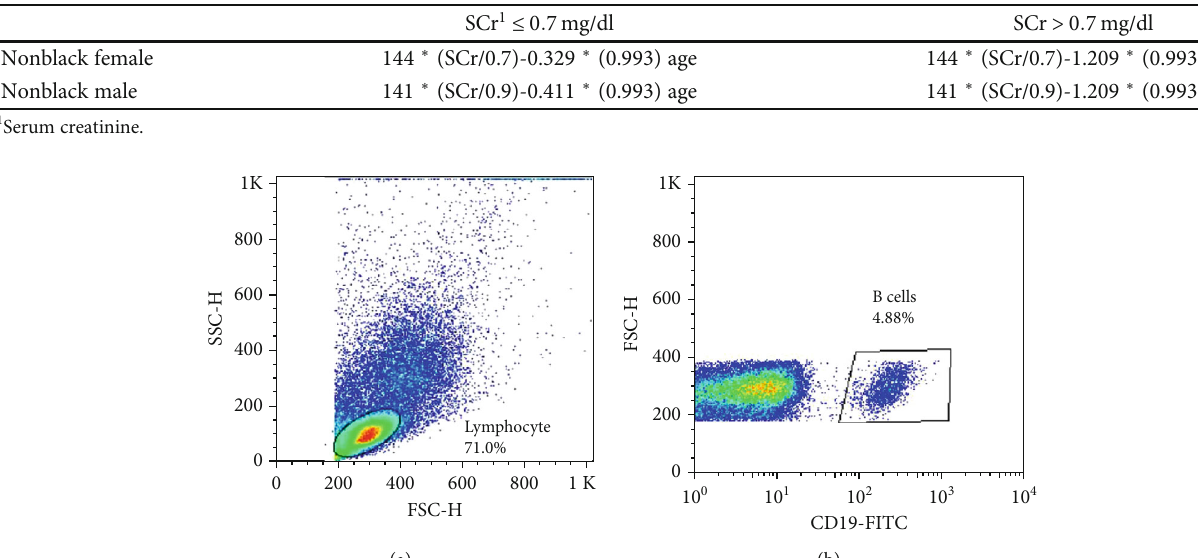
Figure 2: Gating strategy. Forward and side scatter gating for lymphocytes (a). CD19 + cells are displayed as B cells in trapezoidal area